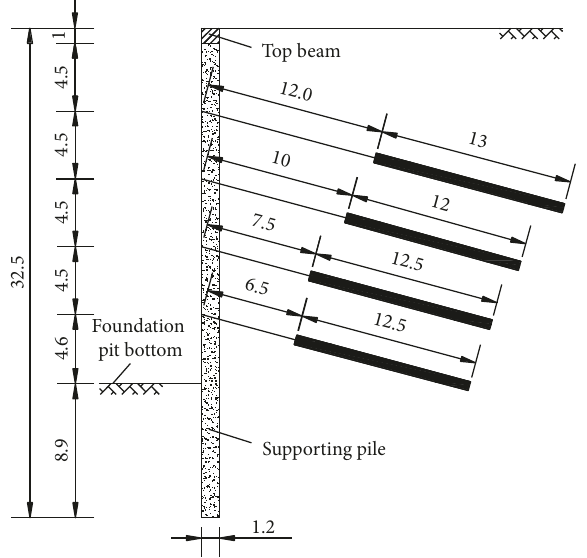
Figure 2: Diagram for calculation of the pile-anchor structure (unit: m). Table 1: Physical and mechanical parameters of main stratum soil.